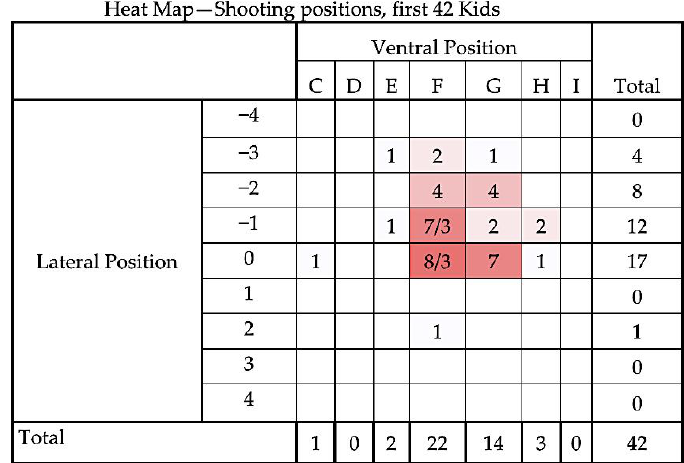
Figure 6. Heat map of the distribution of application positions (right-handed operative) for the first 42 kids. Colour intensity is related to number of applications in each location. Animals euthanised by Euthatal are denoted by highlighted number, for example position − 1F was applied to seven animals, of which three required euthanasia due to the presence of rhythmic breathing post application. Lateral target area, with 0 representing the midline based on the suture of the paired frontal bones with positive values to the left hand side of midline and negative values to the right hand side of midline of the head (see Figure 3). Ventral targeting areas using surface topography with F representing a shot on the frontal-parietal suture, G on the parietal bone, H on the parietal-occipital suture etc. with C rostral to the head (see Figure 4).